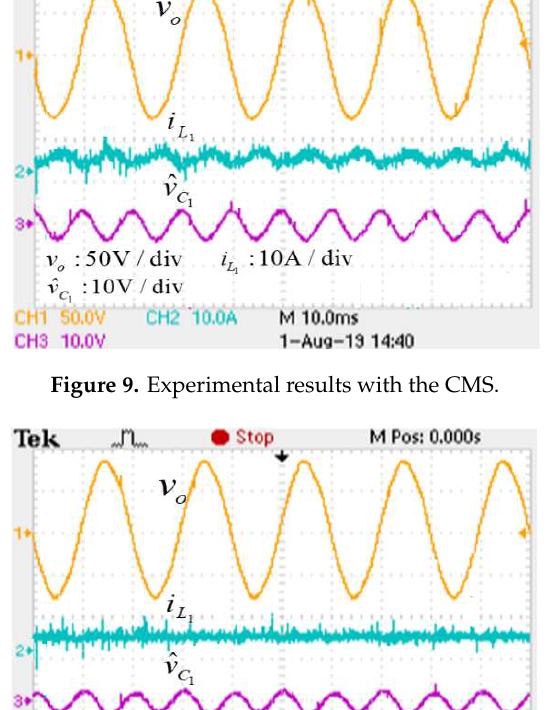
Figure 8. Experimental prototype in the laboratory.